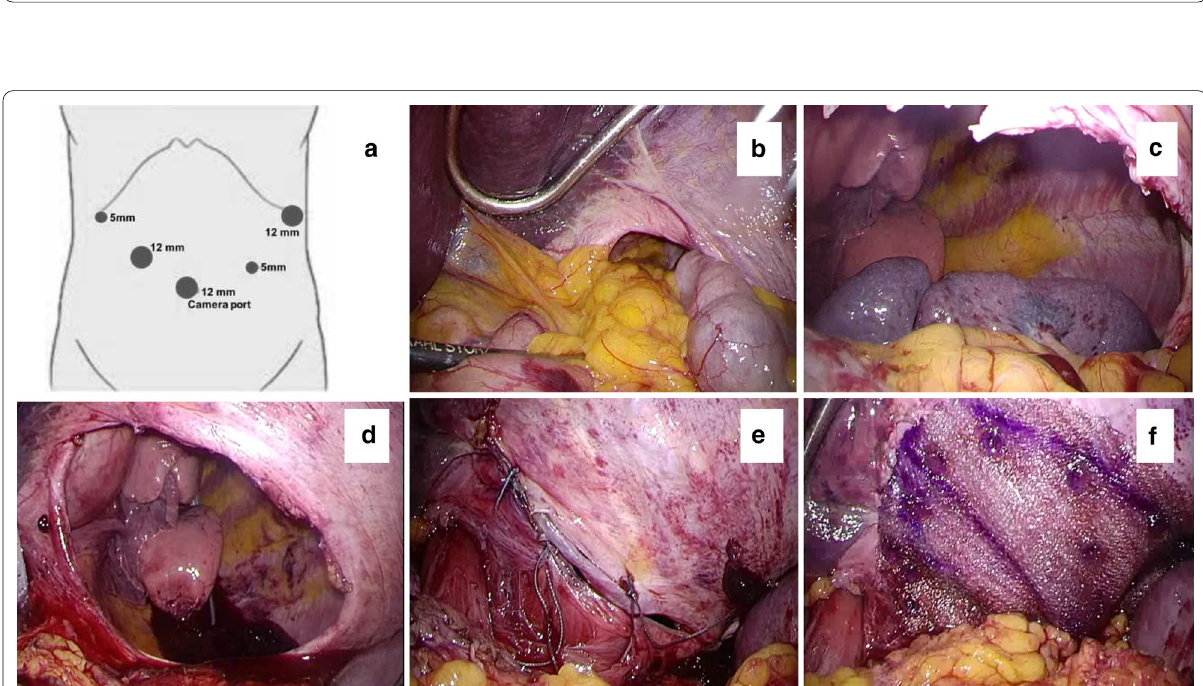
Fig. 2 a Intraoperative views obtained upon laparotomy and port positions for abdominal access. b A large hernial orifice is observed in the left diaphragm, and the prolapsed stomach, small intestine, colon, and pancreas, are seen in the left thoracic cavity. c The spleen is entirely contained within the thoracic cavity due to adhesions. d Upon complete exposure, the hernial orifice is found to be 10 diaphragmatic defect is closed with interrupted nonabsorbable sutures. f The sutured site was reinforced with Ventralight ™ ST